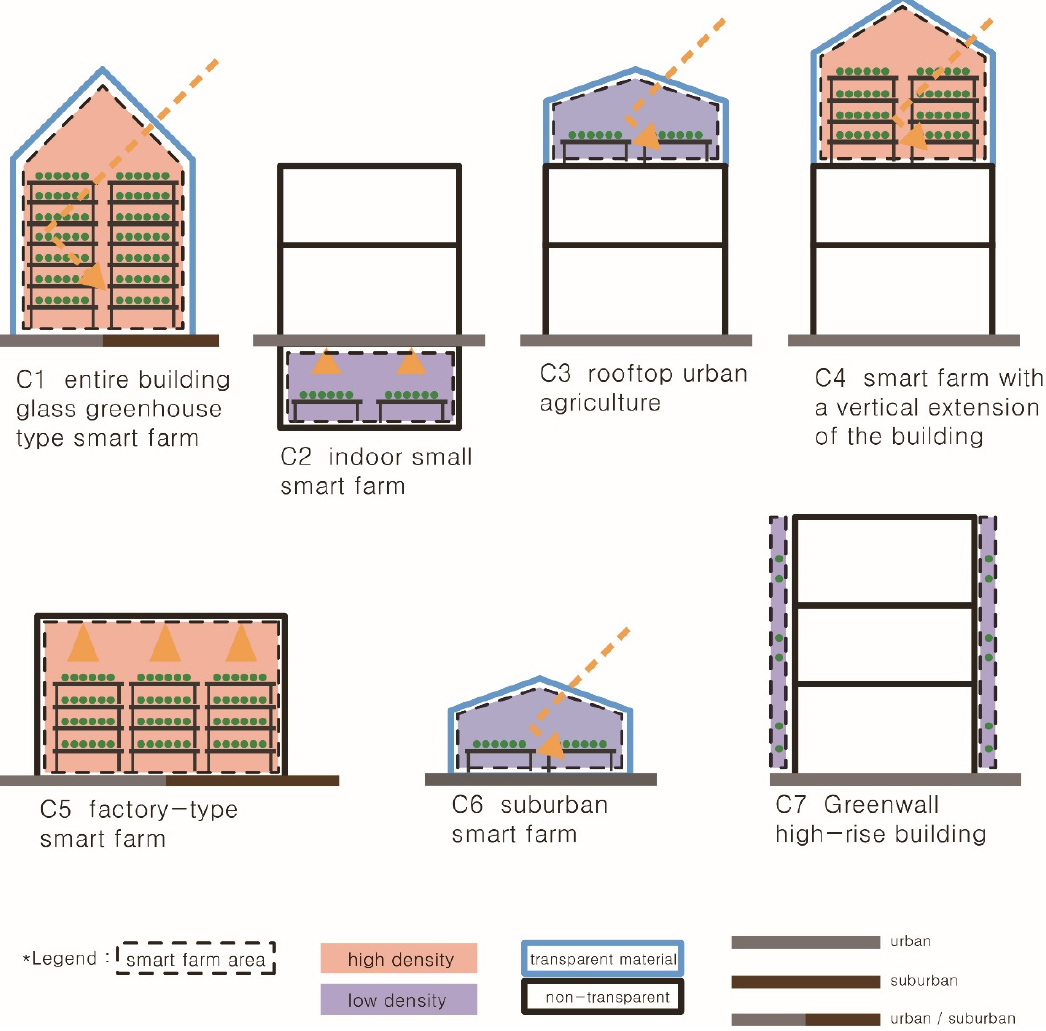
Figure 3. Diagrams of 7 types of architectural characteristics. Table 2. Characteristics of the 7 types of smart farm.